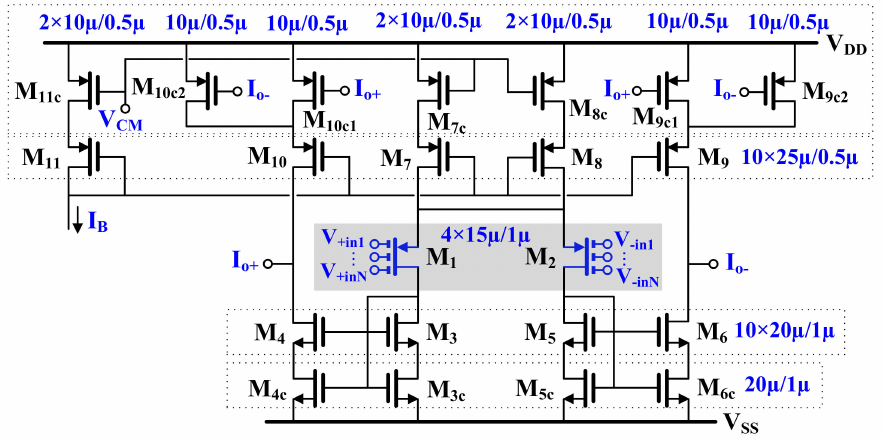
Figure 5. Symbol of a multiple-input operational transconductance amplifier (OTA).